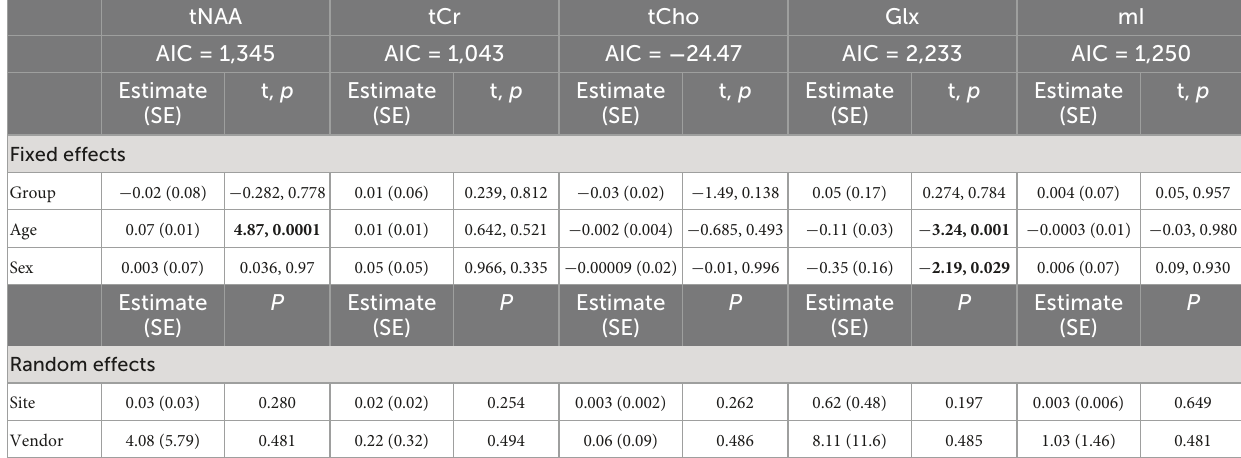
TABLE 3 Details of the linear mixed-effects model with metabolites of interest (tNAA, tCr, tCho, Glx, and mI) as the dependent